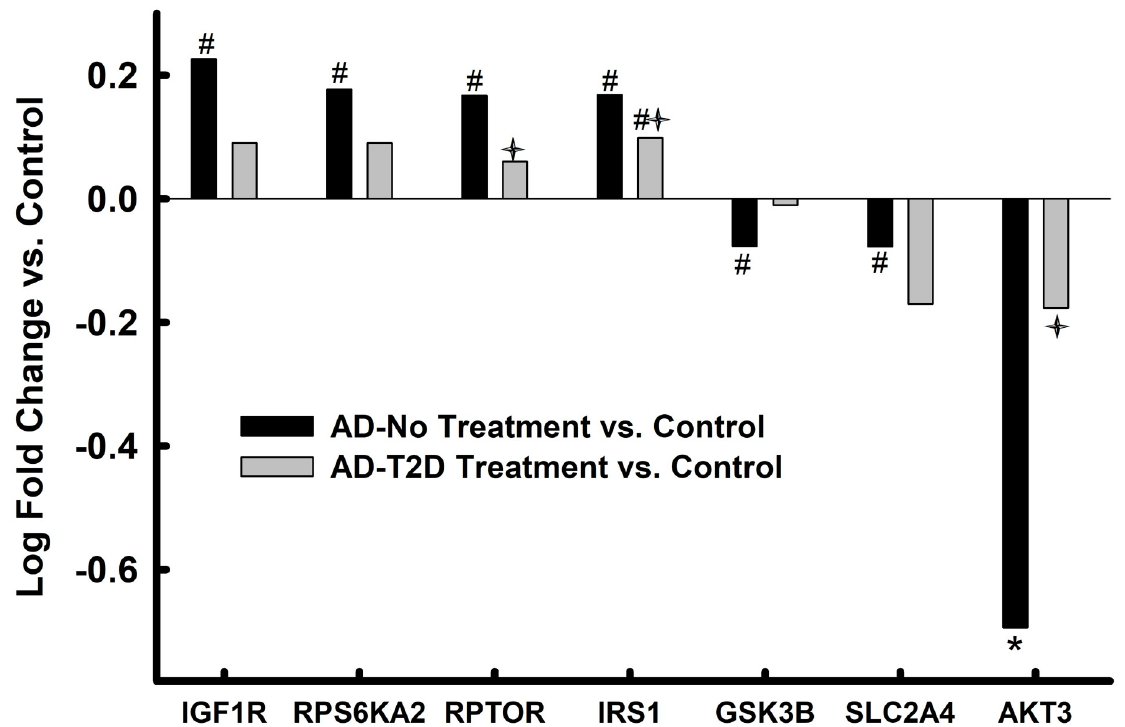
Fig 5. IRSP-associated markers in microvascular enriched isolates from the parahippocampal gyrus. Values represent relative log fold change in persons with AD relative to controls and log fold change in persons with AD and T2D who had been treated with anti-diabetes agents. � = p < 0.05 after FDR correction; # = p < 0.05 without FDR correction; ✦ = p < 0.05 AD-No Treatment vs. AD-T2D Treatment.